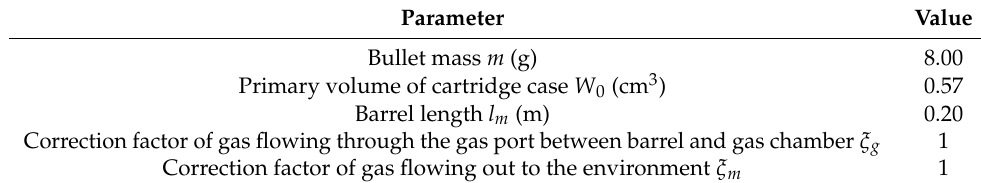
Table 1. Some weapon and ammunition parameters.